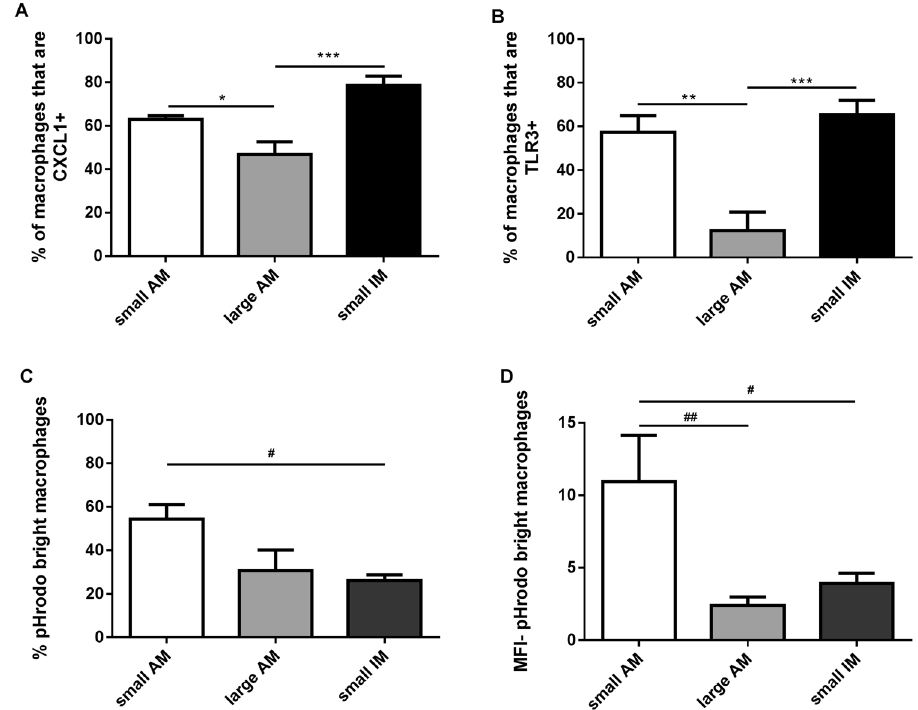
Figure 6. Expression of CXCL1 and TLR3 protein and phagocytosis of pHrodo E. coli BioParticles in macrophage subpopulations. Alveolar (AM) and interstitial (IM) macrophages were isolated using EasySep monocyte enrichment kit. Cells were used to generate cytospin slides ( A and B ) or exposed to pHrodo E. coli BioParticles for 1 h in a shaking incubator ( C and D ). Percentage of small alveolar, large alveolar and small interstitial macrophages expressing CXCL1 protein and TLR3 protein are shown in ( A and B ) respectively. Data represents mean (SEM) of n = 6 COPD patients. Phagocytosis was analysed by flow cytometry and is represented by ( C ): % of pHrodo bright macrophages within each subpopulation and ( D ): median fluorescence intensity (MFI) of each subpopulation relative to the negative control. Data are shown as mean (SEM) of n = 9 COPD patients One way ANOVA followed by Tukey-Kramer Multiple Comparisons Test was performed. * , ** , *** Significantly different compared to expression of the same protein on large alveolar macrophages (p < 0.05, < 0.01 and < 0.001 respectively). #,## Significantly different compared to the percentage of pHrodo bright macrophages or MFI of other macrophage subpopulations (p < 0.05, < 0.01